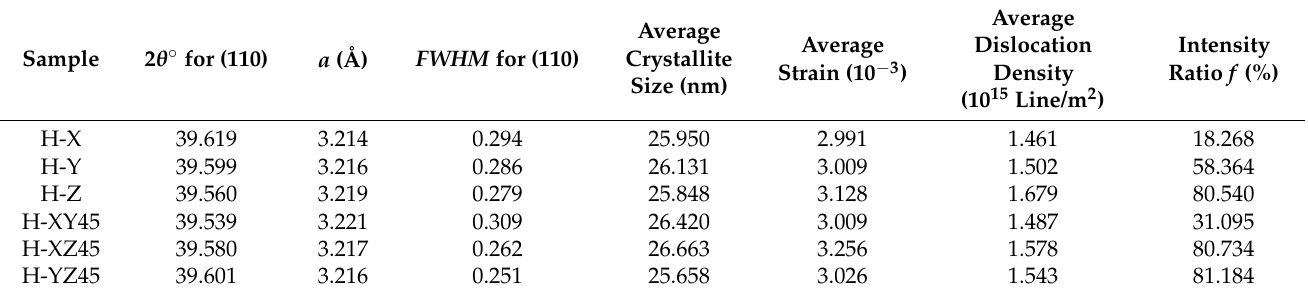
Table 6. The structural parameters of the prior- β phase in aged samples.